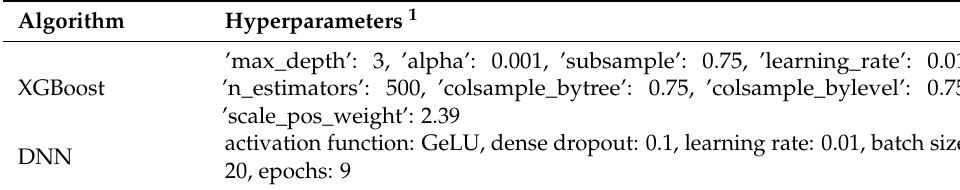
Table 4. Hyperparameters for both models, namely XGBoost and